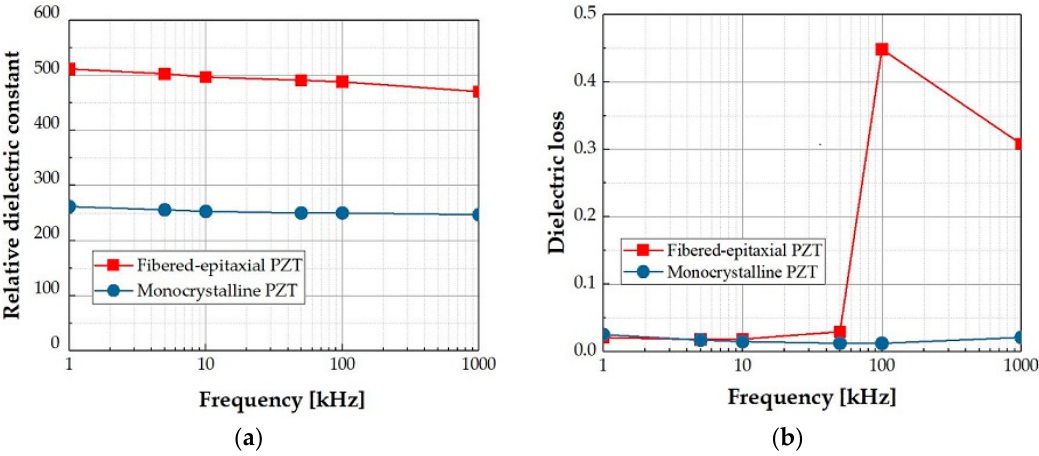
Figure 6. Dependencies of ( a ) the relative dielectric constant and ( b ) dielectric loss on the measurement frequency.